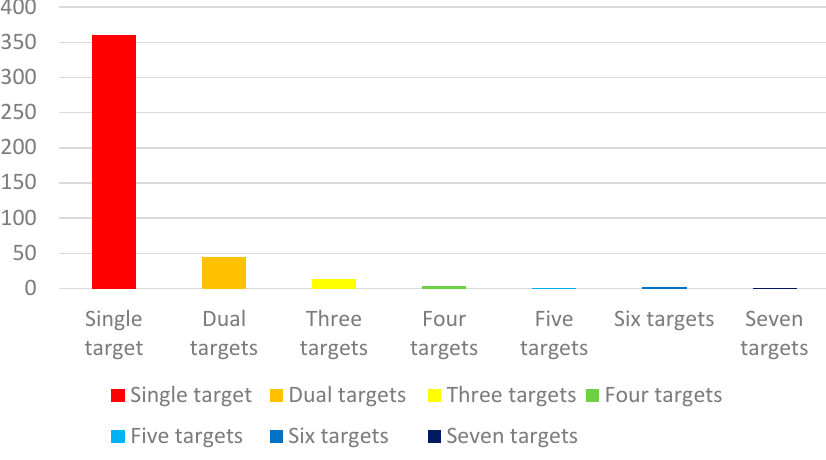
Figure 7. Breakdown by number of targets.